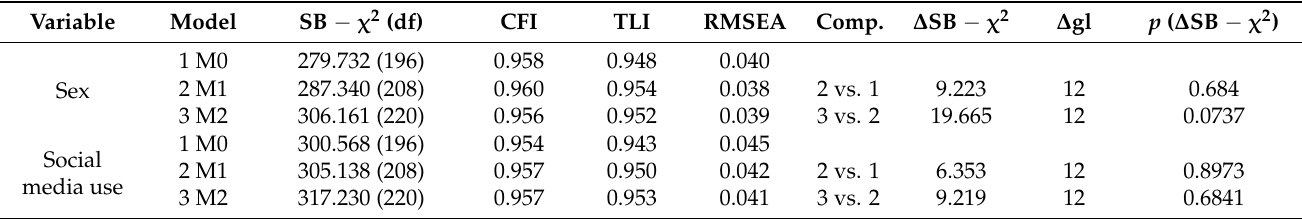
Table 2. Factorial